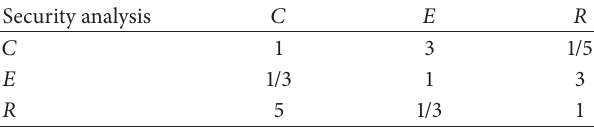
Table 2: Judgment matrix for the security analysis.